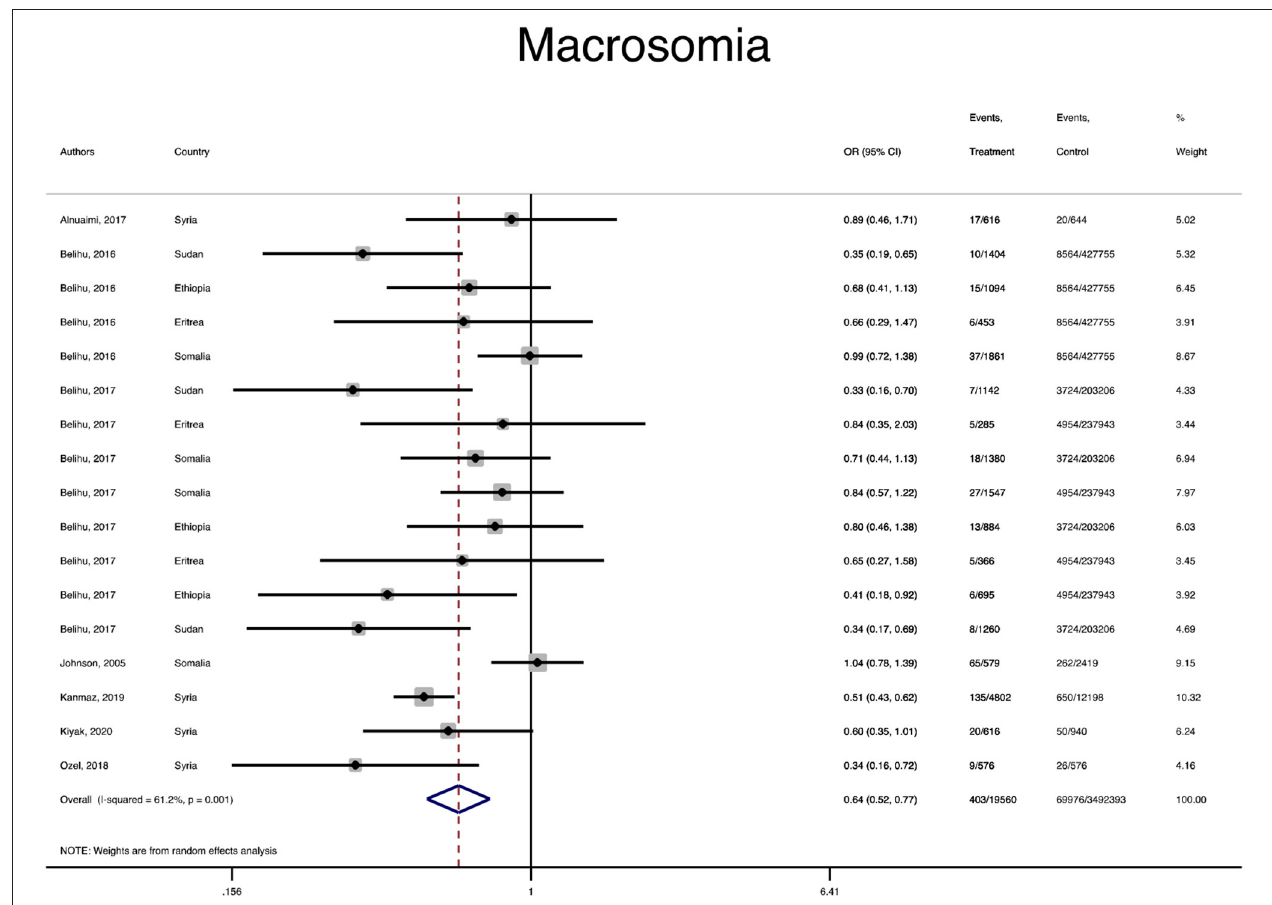
FIGURE 6 | A forest plot of the pooled odds ratio of macrosomia in the immigrant and native-origin